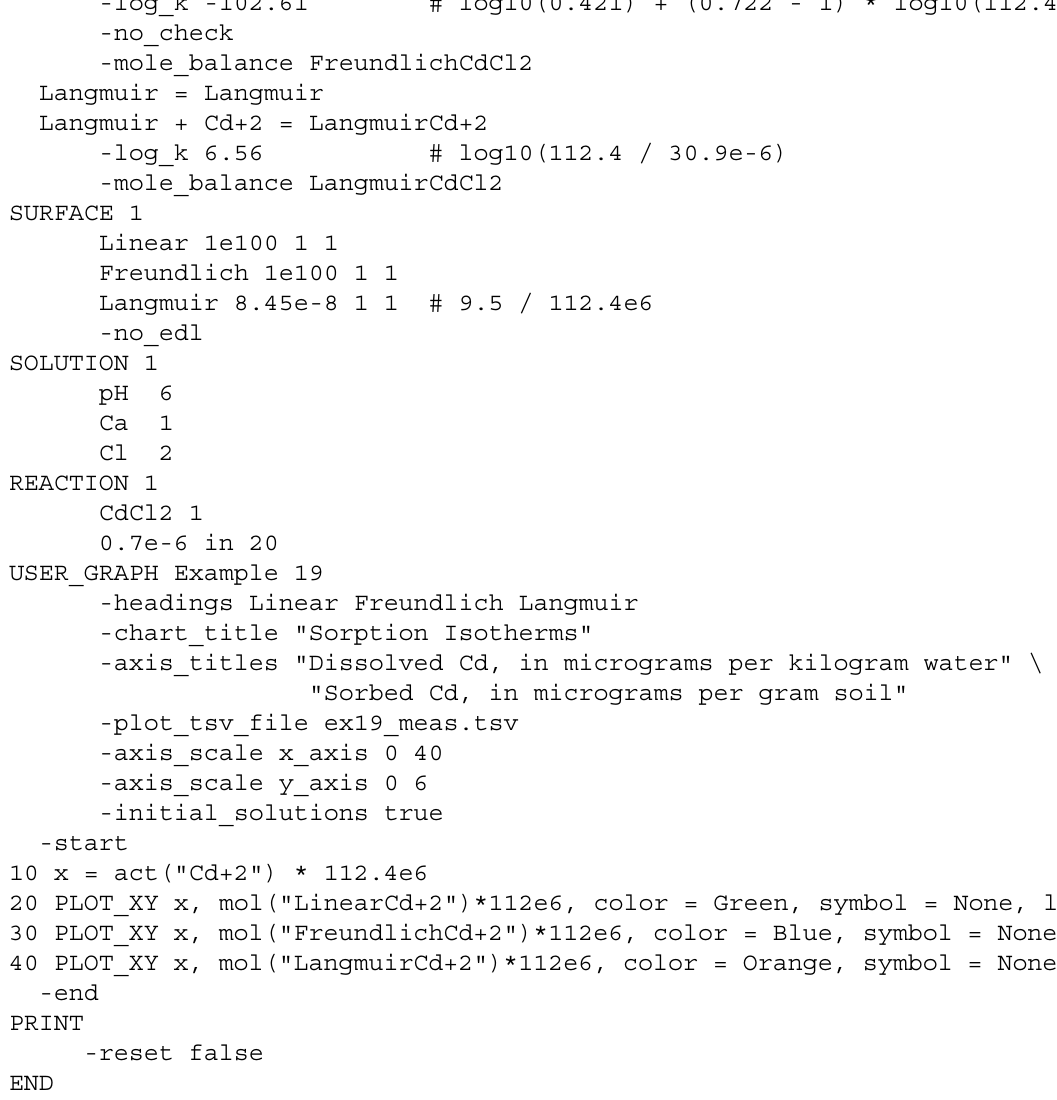
Table 55. Input file for example 19.—Continued Freundlich + 0.722 Cd+2 =